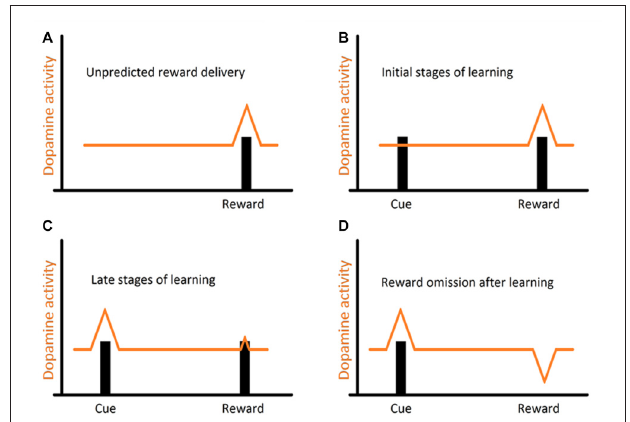
FIGURE 2 | Representation of the evolution of dopaminergic (DA) response (DR) throughout the learning process: (A) usual DR to a novel, unpredicted reward; (B) a reward is presented after displaying a cue. This allows animals to associate the receipt of a reward to the previously displayed cue; (C) after repeated encounters, this DR progressively transfers from the reward itself to the earlier reward-predicting cue, and now animals can expect a reward every time that cue is presented (prediction); (D) however when a reward is predicted but fails to occur (reward omission), a reward-prediction error is signaled.